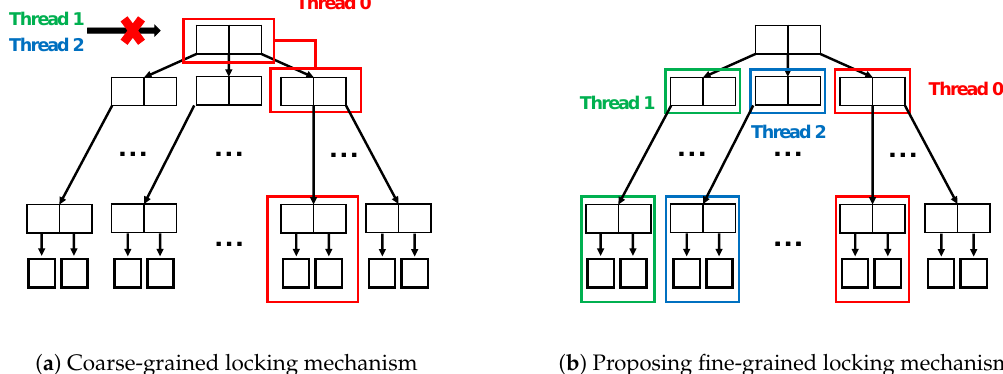
Figure 4. The benefit of the fine-grained locking mechanism of